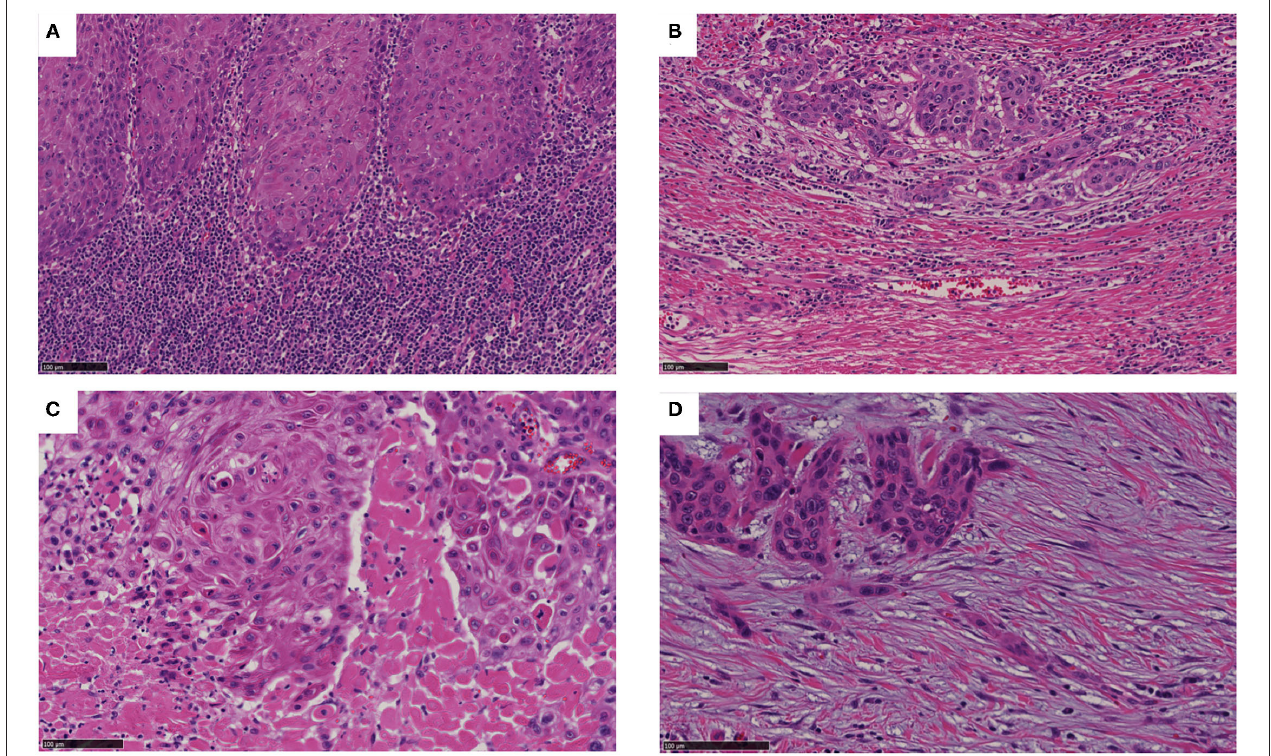
FIGURE 2 | Categorization of SP. (A) The inflammatory type involves an inconspicuous desmoplastic reaction and lymphocytic infiltration into the stroma (as shown). (B) The mature type involves a fibrotic stroma lacking keloid-like collagen and a myxoid stroma. (C) The intermediate type can be identified based on the presence of keloid-like collagen (i.e., fragmented broad bands of collagen exhibiting brightly eosinophilic hyalinization, similar to those seen in a keloid). (D) The immature type can be identified based on abundant amorphous extracellular matrix material in a myxoid stroma. Bar: 100 µ